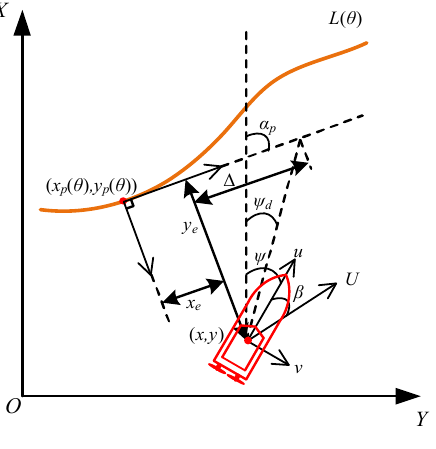
Figure 1. USV path following plan.